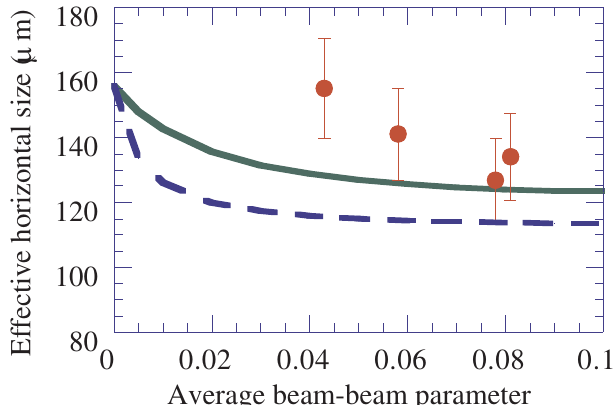
FIG. 11. (Color) The dots are the measured beam-beam kick as a function of the horizontal offset, under the beam condition of FIG. 12. (Color) The dots with an error bar are the estimated scan-1 (a) and scan-2 (b) in Table III. The solid line is the effective horizontal beam size as a function of the average beam- calculated beam-beam kick, assuming each horizontal beam size beam parameter. The green solid line is the calculated size with a (cid:5) 110 (cid:11) m (a) and (cid:7) (cid:8) (cid:5) 90 (cid:11) m (b) and the is equal with (cid:7) (cid:8) fractional tune of 0.540 and the blue dashed line with a tune of x x (cid:5) 2 (cid:11) m in both cases. vertical size is (cid:7) (cid:8) y